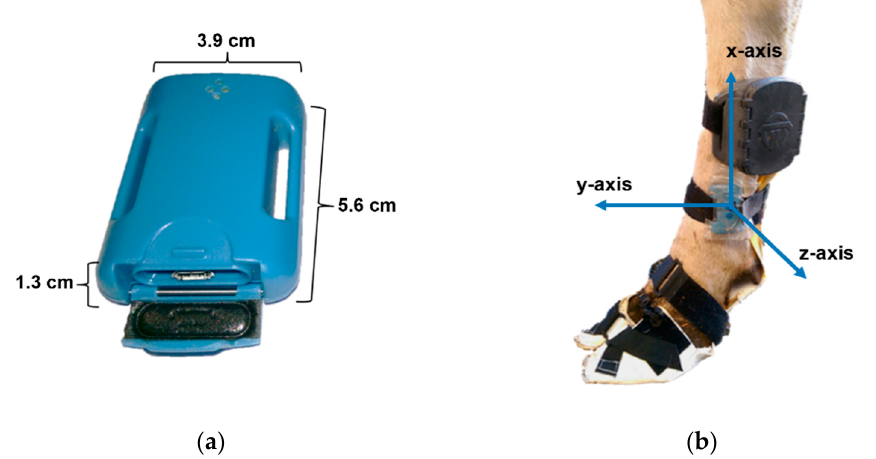
Figure 2. ( a ) Inertial measurement unit (IMU) dimensions; ( b ) orientation of an IMU (blue arrows) attached to the metatarsus above the claw shoe of the left hind limb.